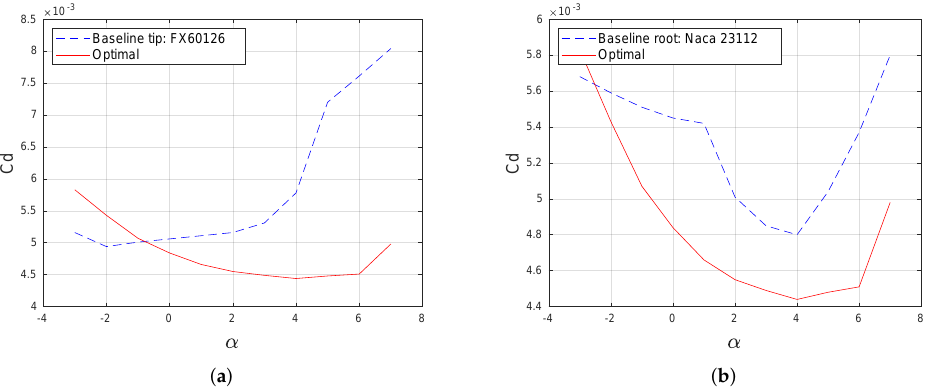
Figure 10. Parasitic drag coefficient comparison between baseline and optimized tip ( a ) and root airfoils ( b ).